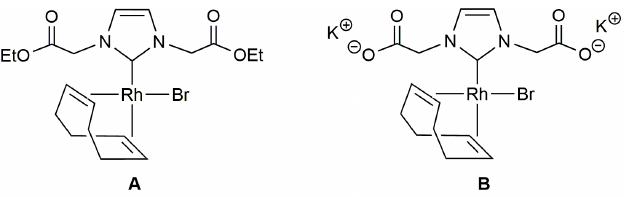
Figure 1. Structure of the first water-soluble NHC-metal complexes reported in the literature.